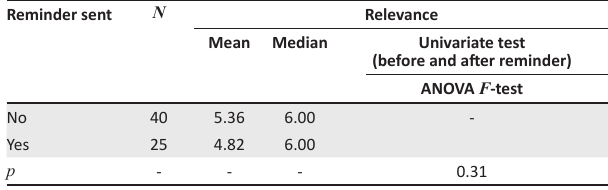
TABLE 8: Univariate results of reminder sent.